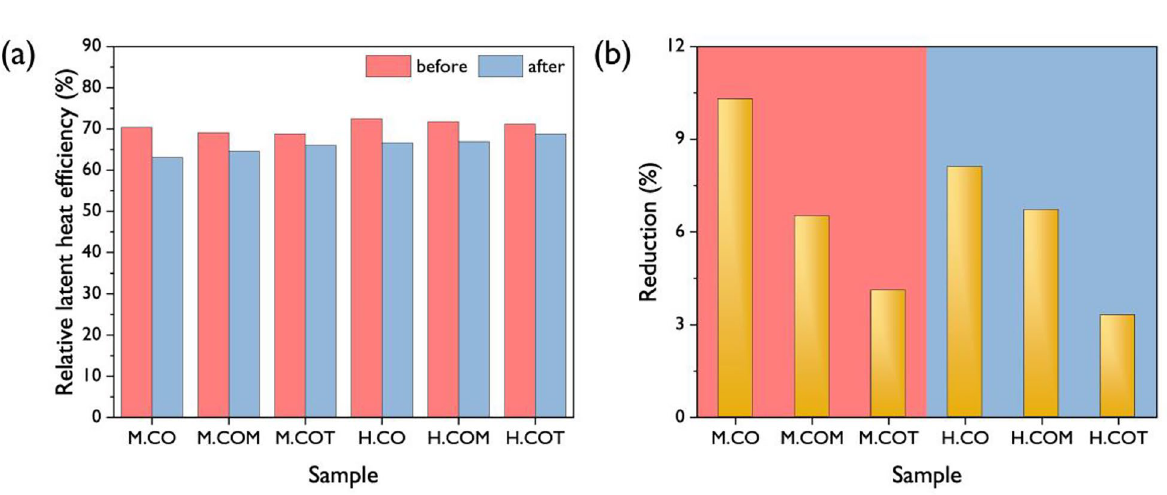
Figure 9. ( a ) Relative latent heat efficiencies of the SSPCMs before and after the accelerated thermal cycling tests and ( b ) the reduction in relative latent heat